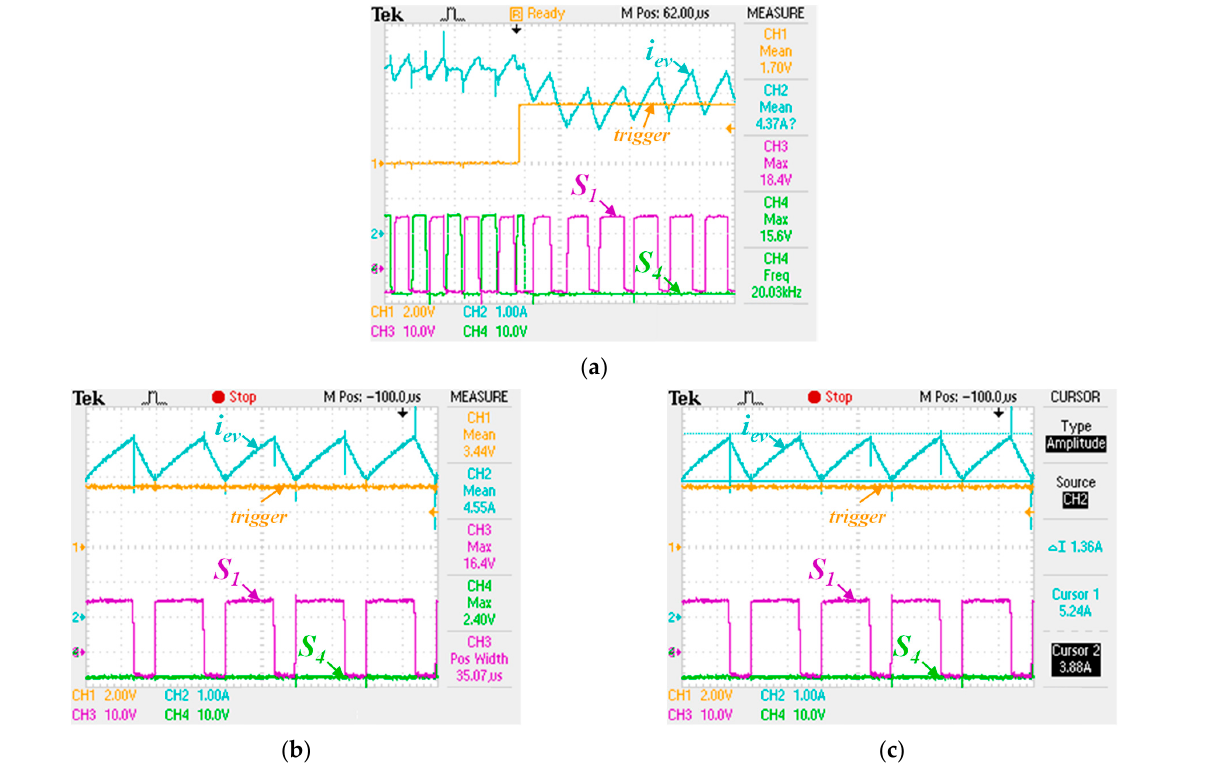
Figure 18. Transient-state operation of the multilevel dc–dc converter following a failure in the negative wire of the bipolar dc grid: ( a ) transition time from normal conditions (trigger value of 0 V) to fault conditions (trigger value of 3.3 V); ( b ) an i ev of 5 A and a duty cycle of 70% for semiconductor S 1 , while that of S 4 is equal to 0%; ( c ) an i ev ripple value of 1.36 A.